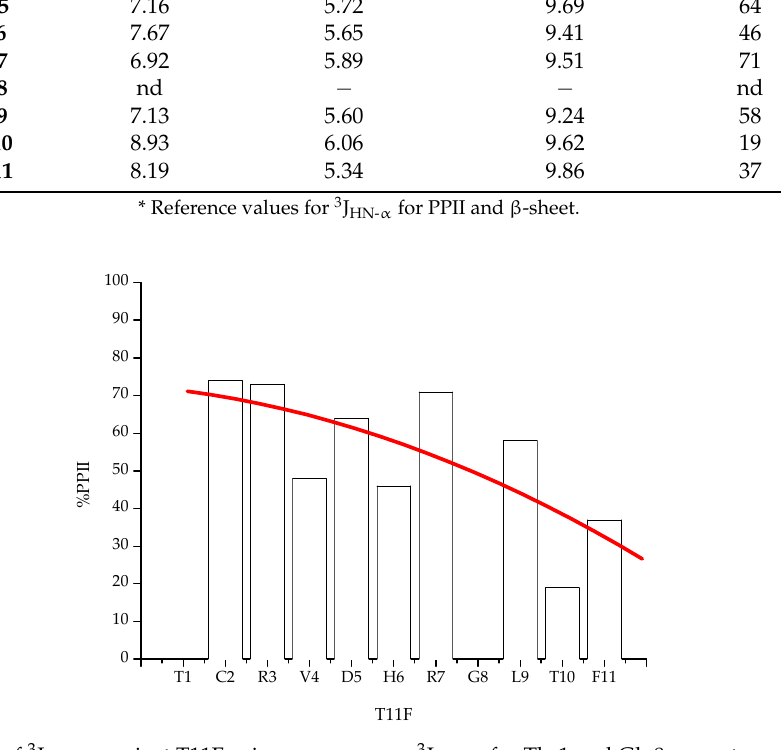
Figure 4. Plot of 3 J HN- α against T11F primary sequence. 3 J HN- α for Thr1 and Gly8 are not measurable.